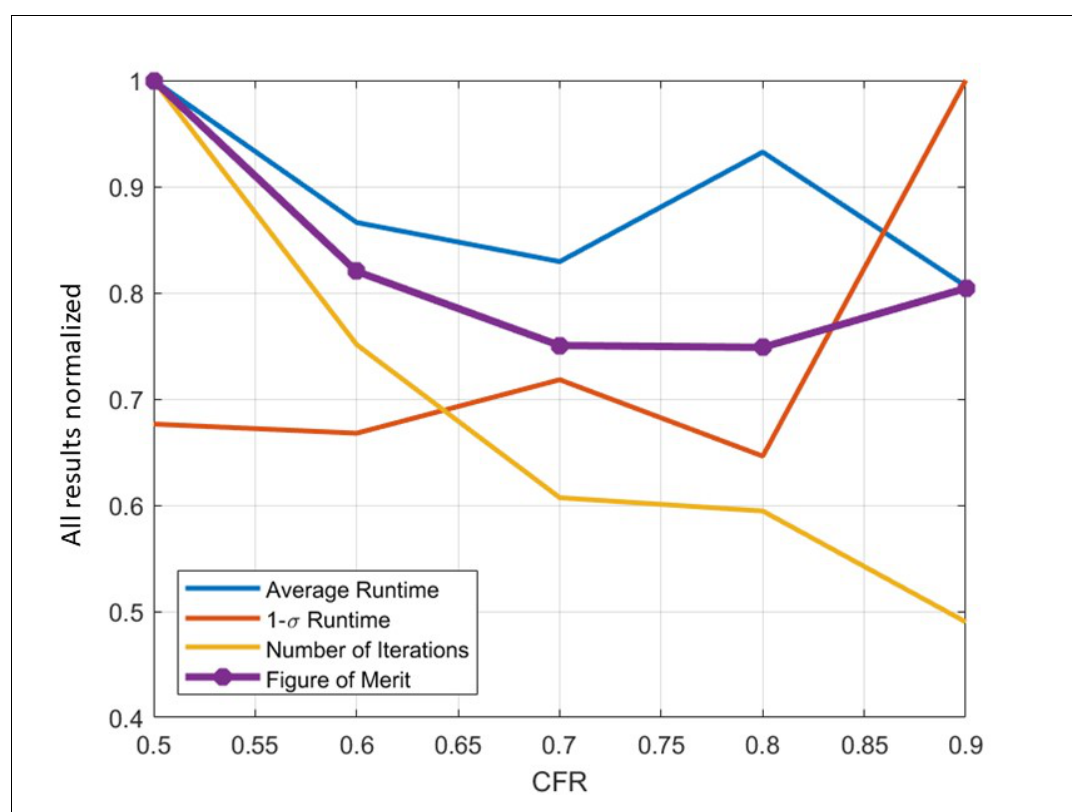
Figure 7. Simulation results for the average total run time (blue), the standard deviation of the total run time (red), the average number of iterations (yellow), and the figure of merit